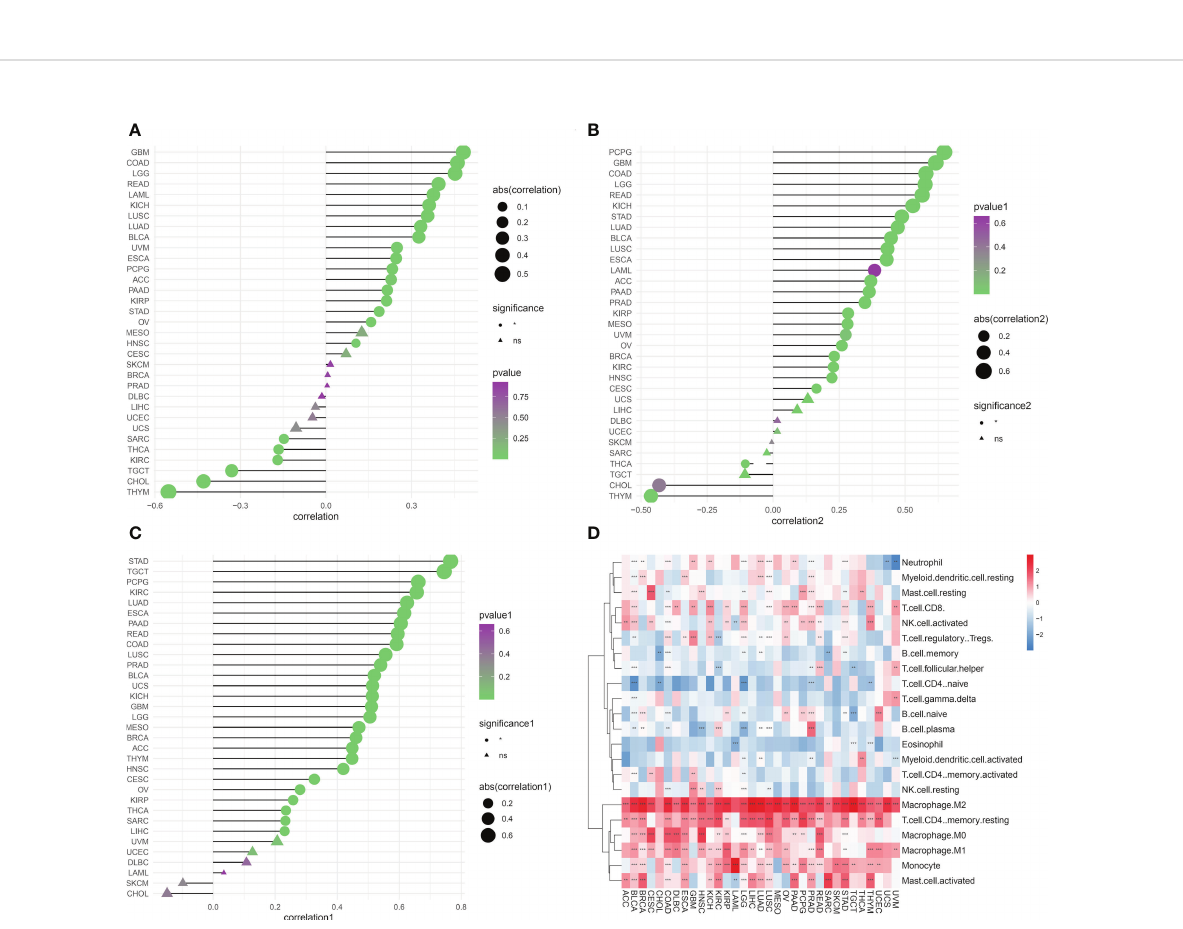
FIGURE 7 Migrasome scores are closely related to immune cell in fi ltration. (A) Analysis of tumor ImmuneScore. *P < 0.05, **P < 0.01, ***P < 0.001, and NS, no signi fi cant. (B) Analysis of tumor MicroenvironmentScore. *P < 0.05, **P < 0.01, ***P < 0.001, and NS, no signi fi cant. (C) Analysis of tumor StromaScore. *P < 0.05, **P < 0.01, ***P < 0.001, and NS, no signi fi cant. (D) A heat map depicting the correlation between migrasome expression in cancer and tumor immune in fi ltration. **P < 0.01, ***P < 0.001.